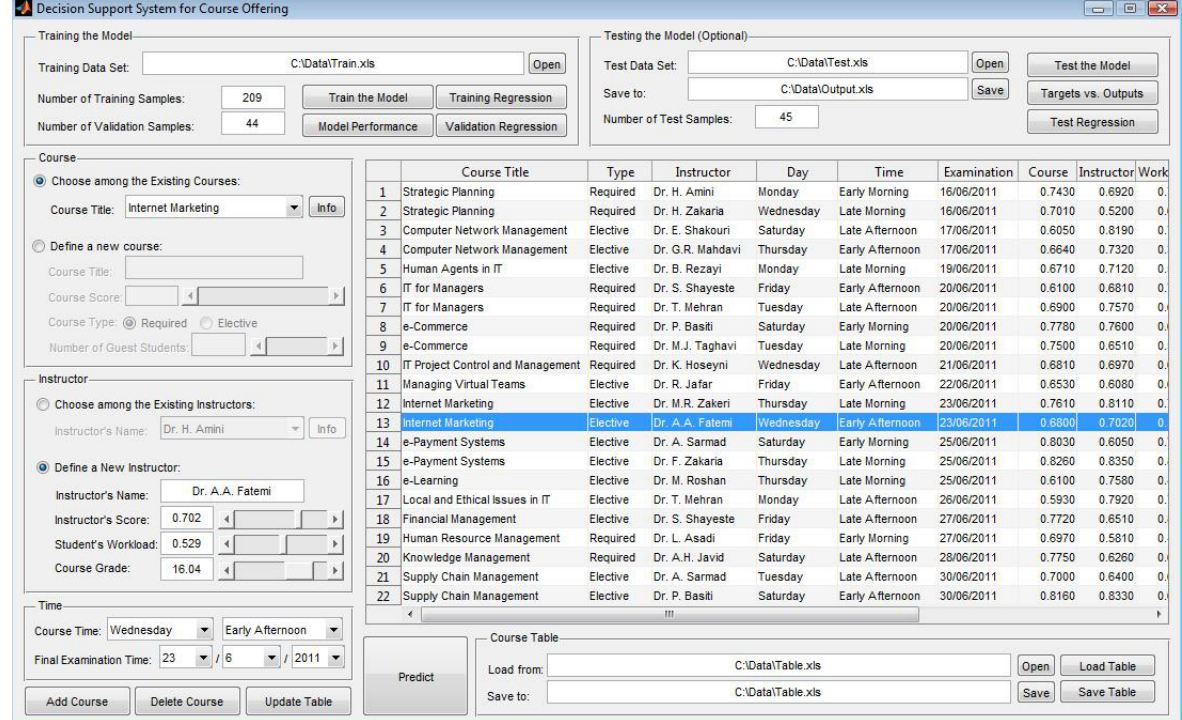
Fig. 7. The user interface of the proposed